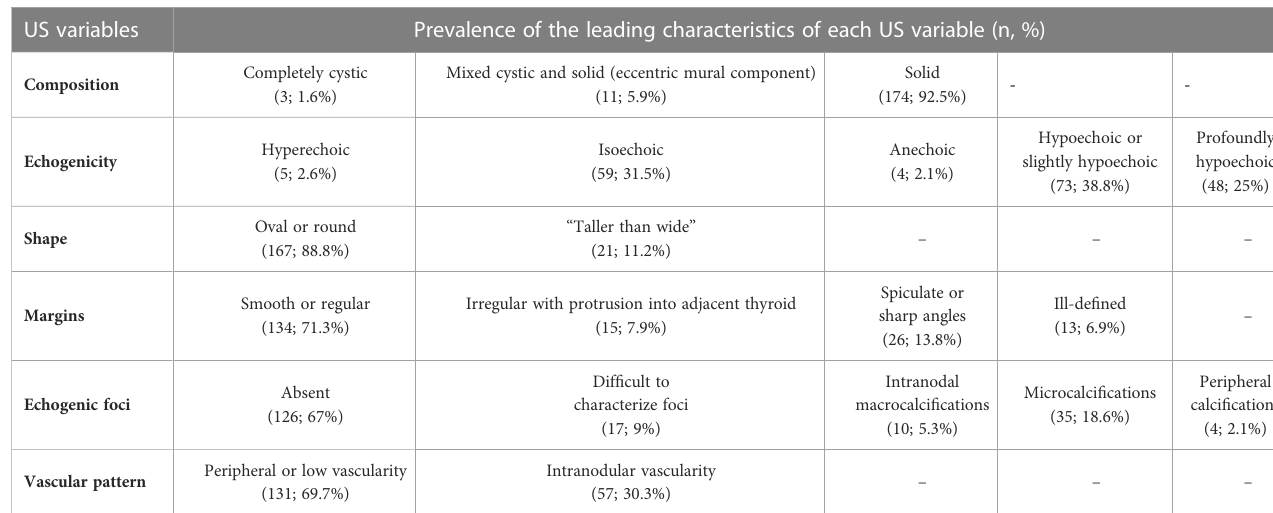
TABLE 1 Ultrasonographic characteristics of examined thyroid nodules (n =